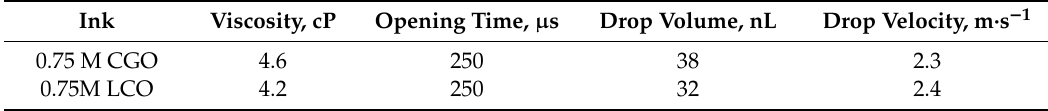
Table 3. Infiltrate inks: compositions and jetting parameters. *